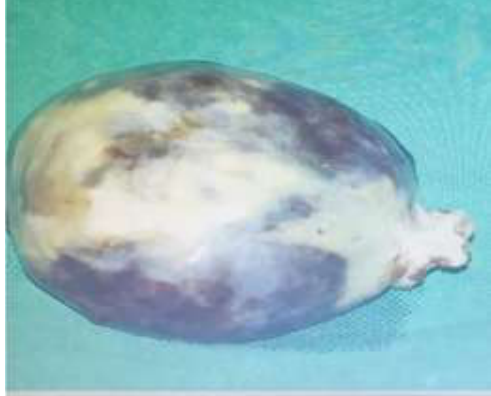
Figure 2. Resected pedunculated